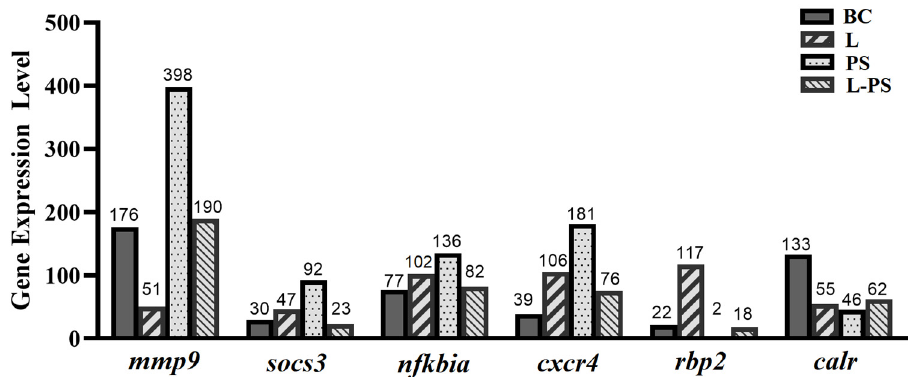
Figure 10. Expression levels of six differentially expressed genes obtained through RNA-Seq.